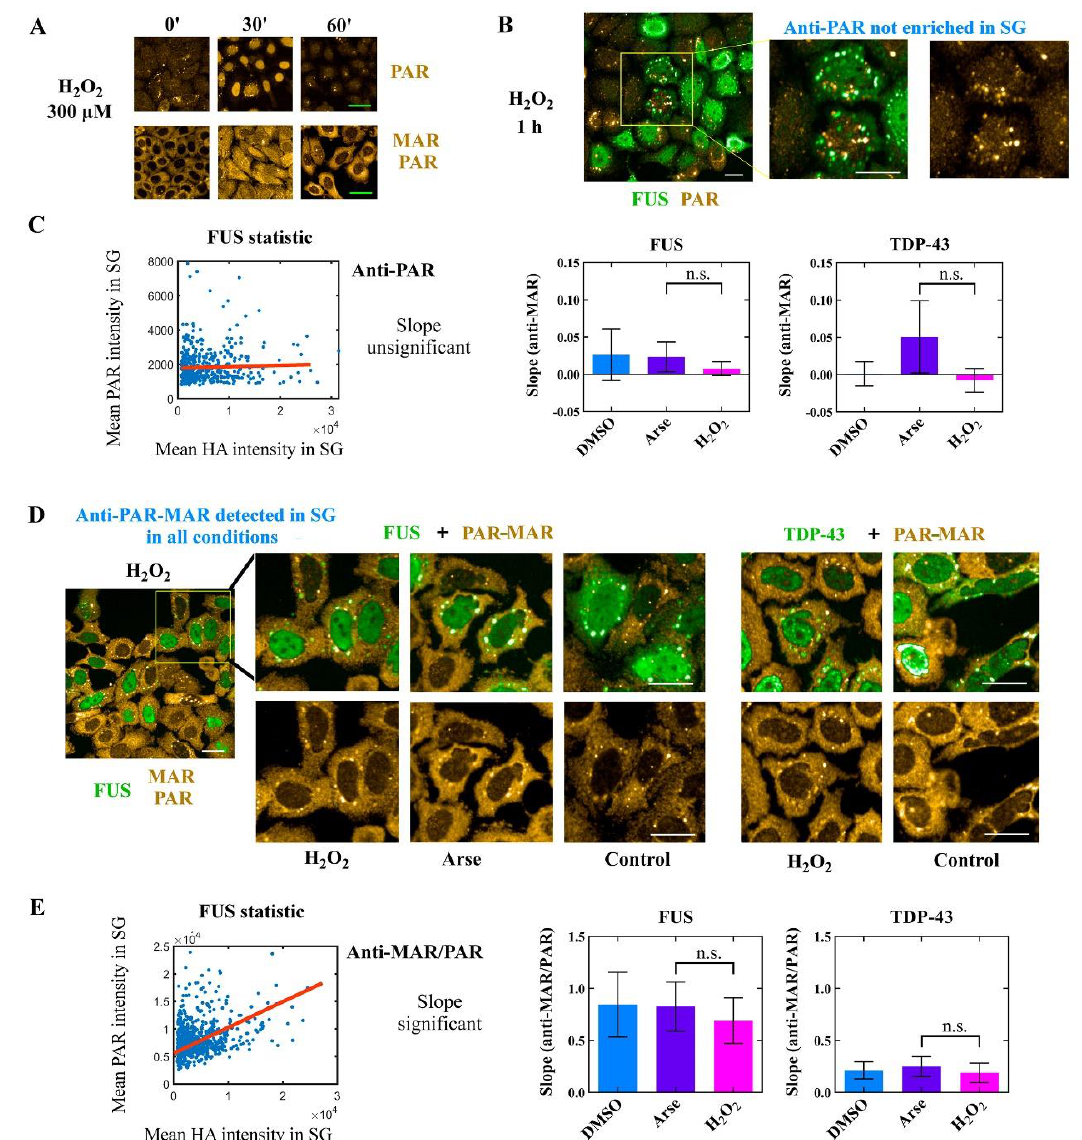
Figure 3. The enrichment of MAR/PAR in SGs is not impacted by oxidative cellular stress (arsenite or H 2 O 2 ). ( A ) HeLa cells were exposed to 300 µM H 2 O 2 for the indicated time. After 60 min exposure to H 2 O 2 , PAR was rapidly digested in the nucleus by PAR-degrading enzymes (PARG and others). Cells were fixed with methanol. Scale bar: 10 µ m. ( B ) HA-tagged FUS was overexpressed in HeLa cells to generate SG assembly in the cytoplasm in the absence of additional stress. Then, cells were exposed to DMSO, arsenite or H 2 O 2 (300 µM for 60 min). Anti-PAR antibody was not detected in SGs. Green: anti-HA antibody. Gold: anti-PAR antibody. Scale bar: 10 µ m. Similar results were obtained after 30 min incubation with H 2 O 2 . Confocal images were obtained with an imager Opera Phenix plus. ( C ) Measurement of the slope under indicated conditions (same as ( B )). Mean enrichment (SG-to-cytoplasmic-intensity ratio) of anti-PAR and anti-HA antibodies was measured in SGs formed after overexpressing either HA-tagged FUS or TDP-43. No influence of the experiment condition on PAR level was detected, n.s.: not significant. ( D ) The same conditions as in ( B ), except the using of anti-MAR/PAR antibody to detect MAR/PAR in the cytoplasm. In this case, MAR/PAR was detected in SGs in all tested conditions. Green: anti-HA antibody. Gold: anti-PAR antibody. Scale bar: 10 μm. ( E ) Measurement of the slope under indicated conditions (same as in ( D )). A positive slope indicates correlation between the number of HA-tagged proteins recruited to the SGs and MAR/PAR signal, n.s.: not significant.